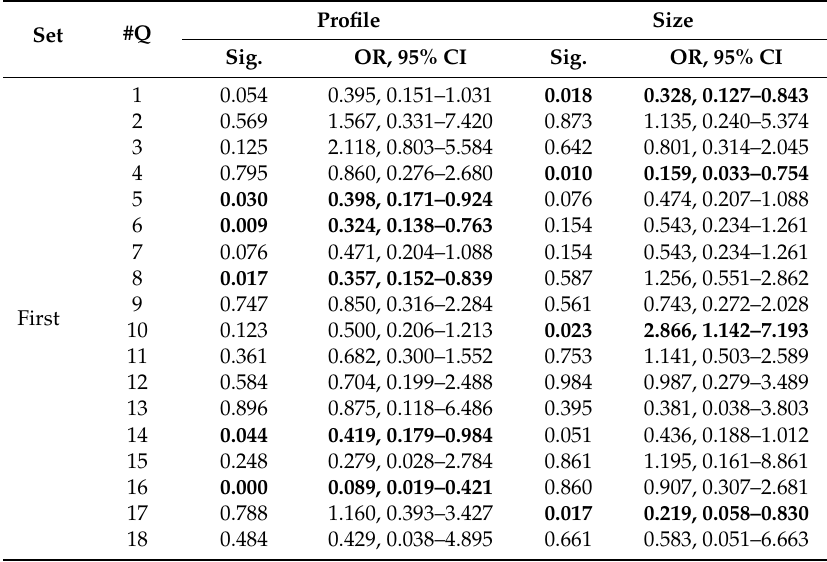
Table 4. Summary of the results of the statistical